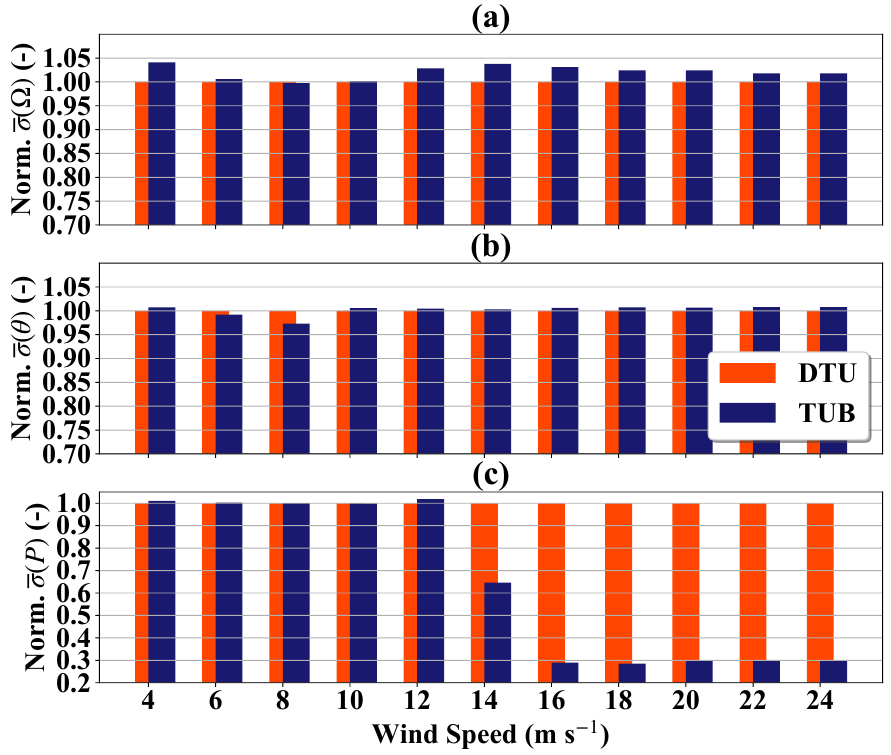
Figure 9. Normalized average standard deviations of controller signals vs. wind speed. ( a ) Rotor speed; ( b ) Pitch angle; ( c ) Generator power. Nomenclature of the signals is found in Table